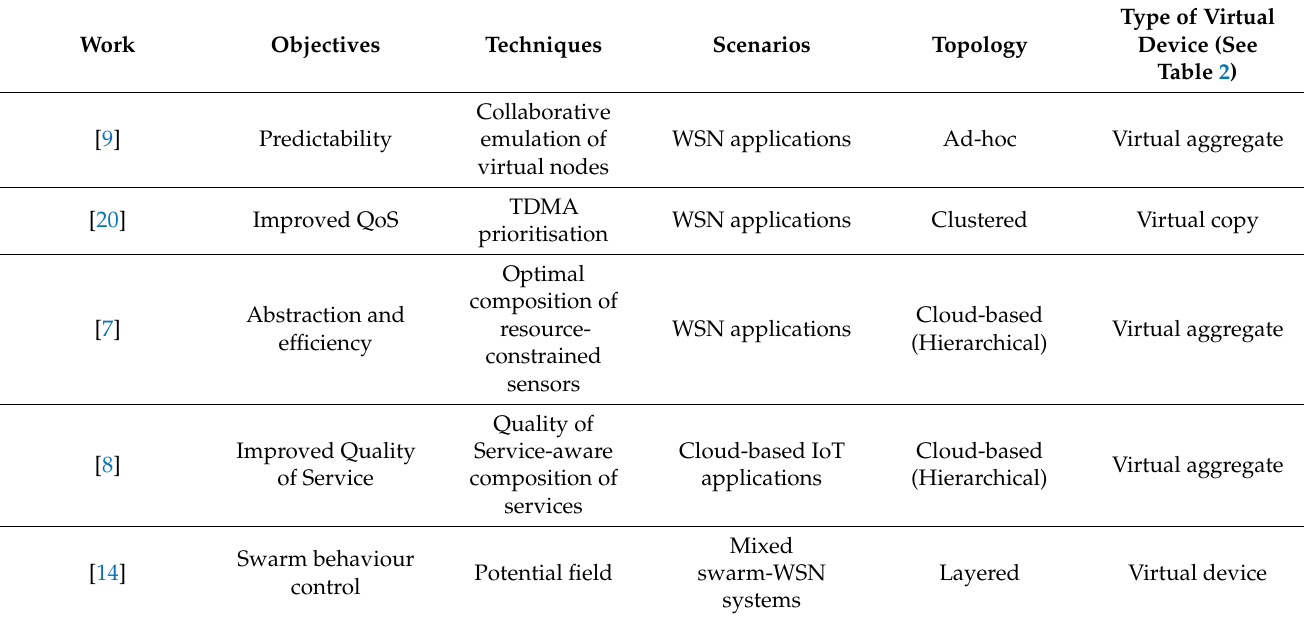
Table 1. Occurrences of “virtual nodes” in the literature.